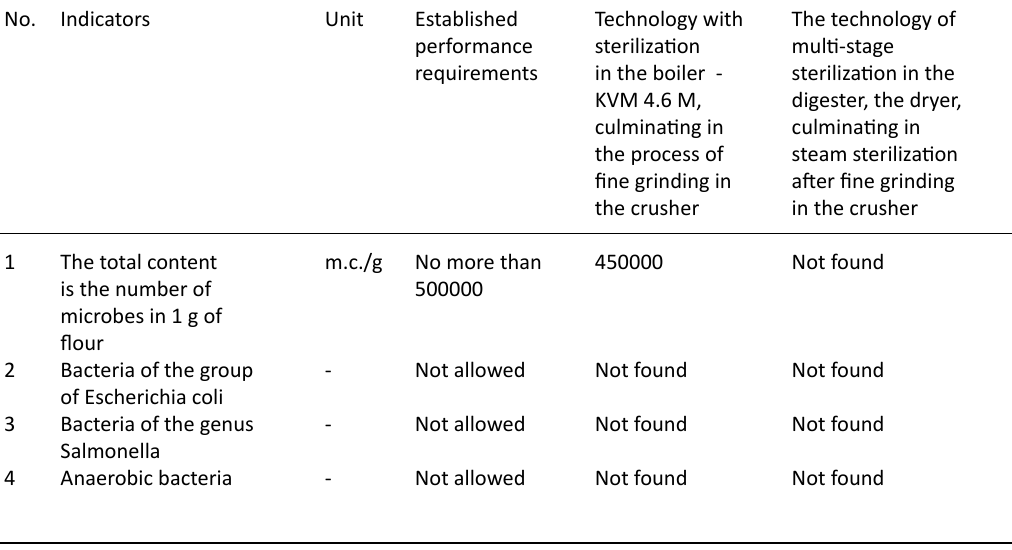
Table 1. Microbiological assessment of the quality of feed meal from animal waste produced by two technologies No.